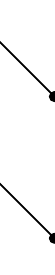
Figure 3. The tree F